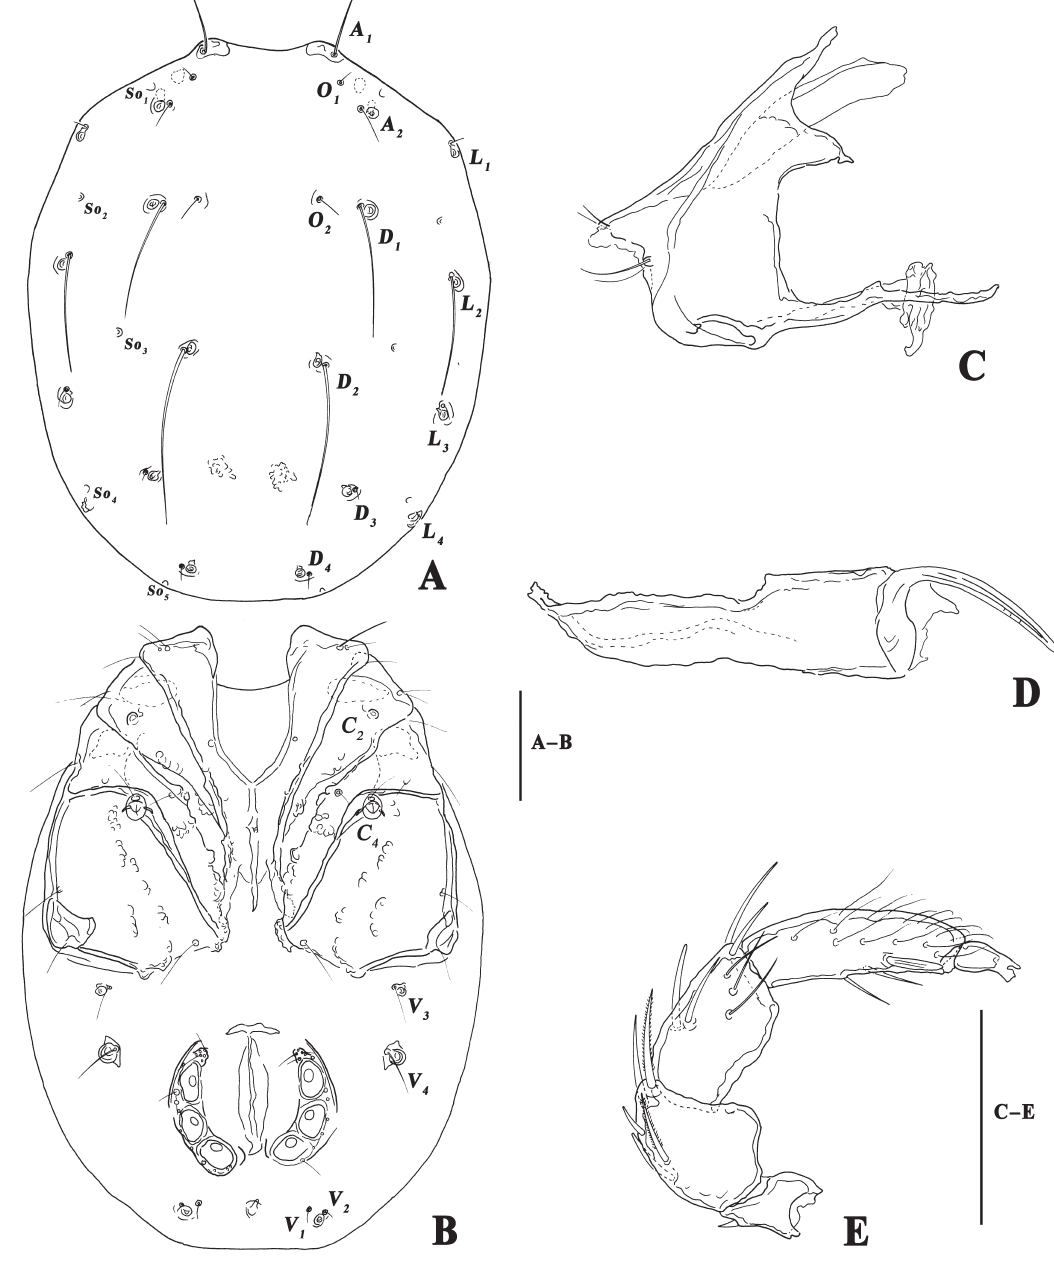
Fig. 9. Atractides ( Atractides ) longiprojectus Zhang, Li & Guo sp. nov., holotype, ♀ (GUGC, Slide No. QH-HY-2020072907). A . Idiosoma, dorsal view. B . Idiosoma, ventral view. C . Gnathosoma. D . Chelicera. E . Palp. Scale bars = 100